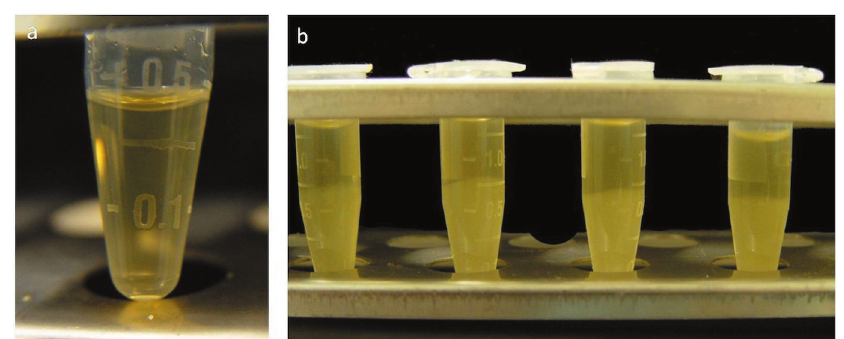
Figure 3- Bacterial viability after 14 days assessed by the turbidity of the brain heart infusion (BHI) broth. A: negative control; B: bacterial growth to confirm